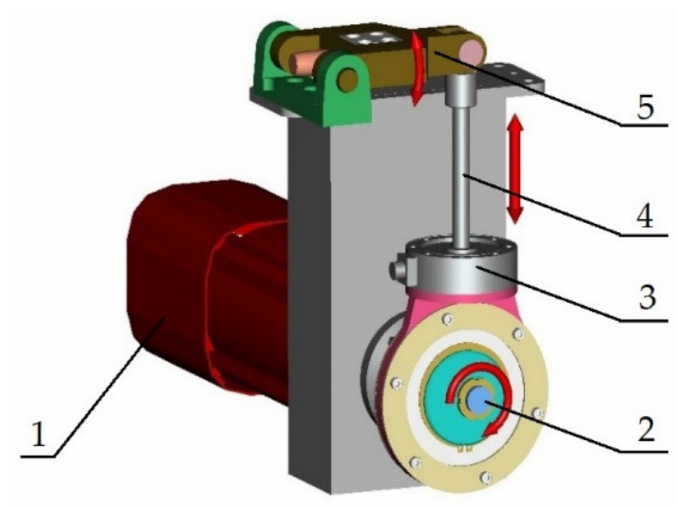
Figure 3. The 3D model of the designed mechanism for cyclic loading the tested material by bending: 1—servomotor SEW-EURODRIVE CFM90S; 2—eccentric system; 3—scanner of force; 4—capstan;